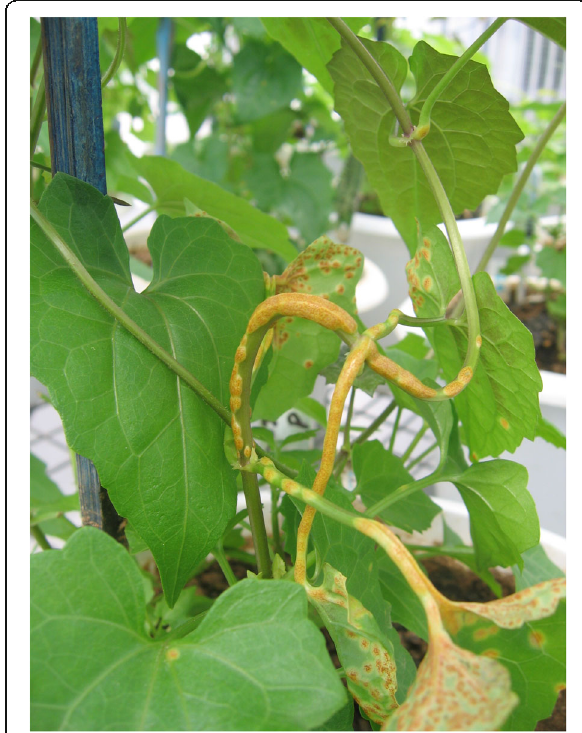
Fig. 3 A representative Mikania micrantha plant from Assam infected with the Peruvian pathotype of Puccinia spegazzinii